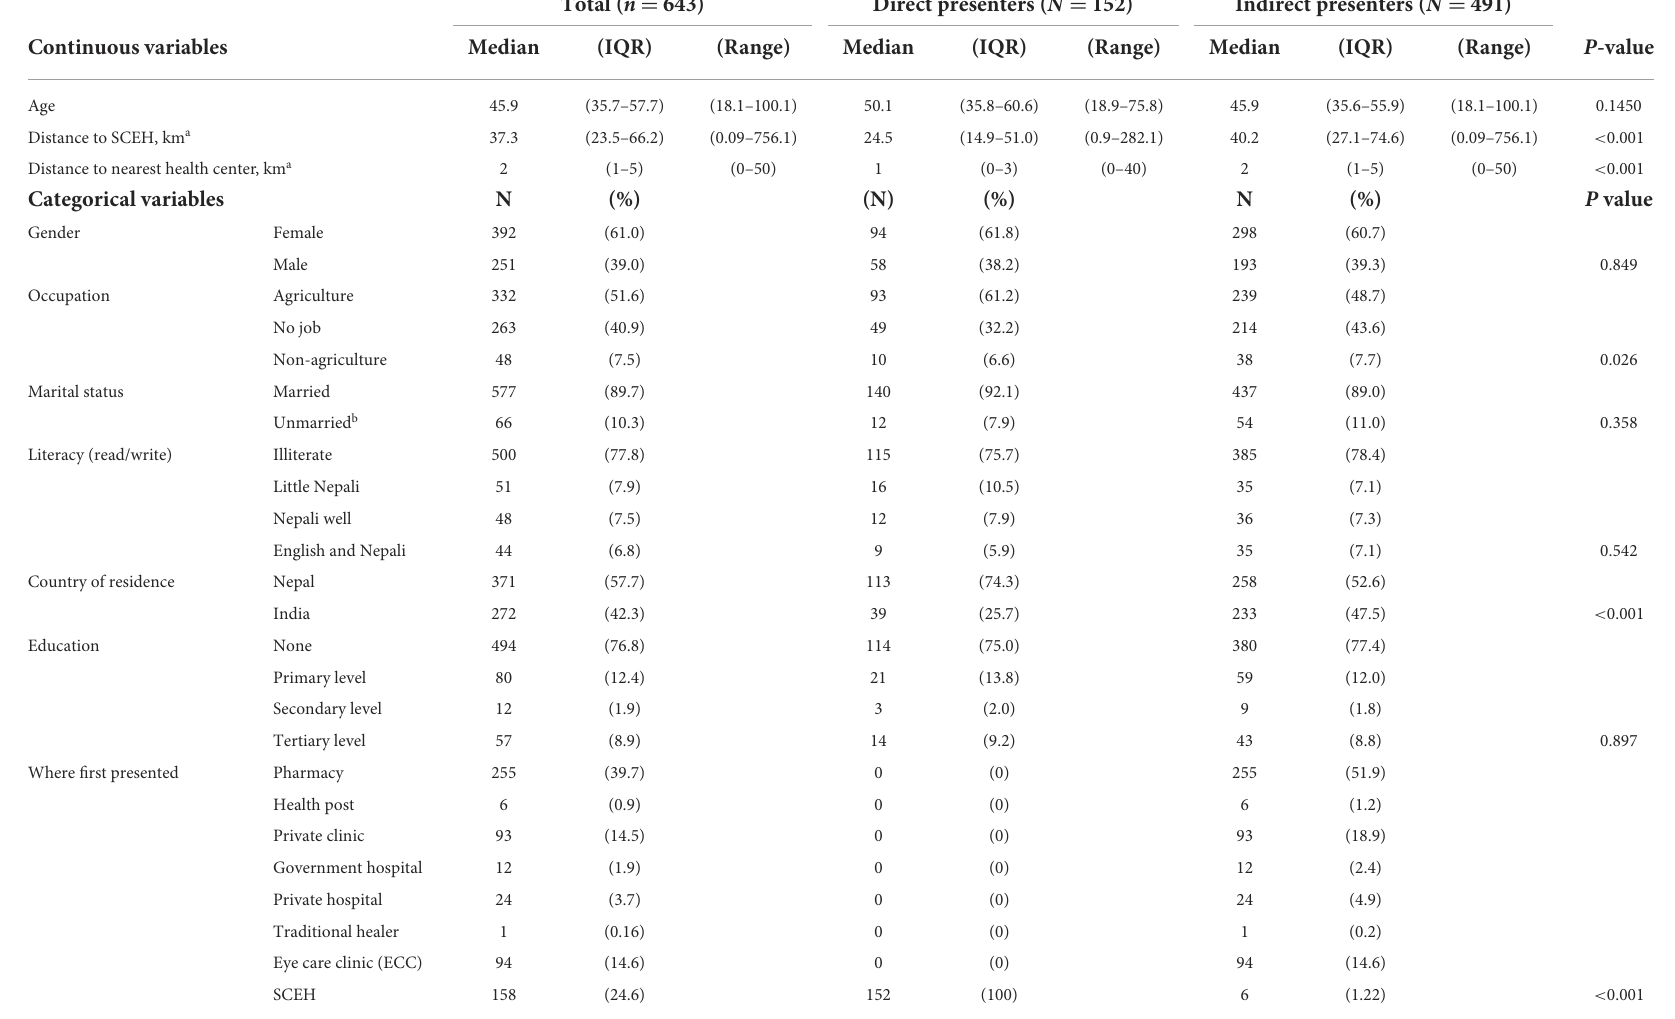
TABLE 1 Baseline characteristics of direct vs. indirect presenters, n =